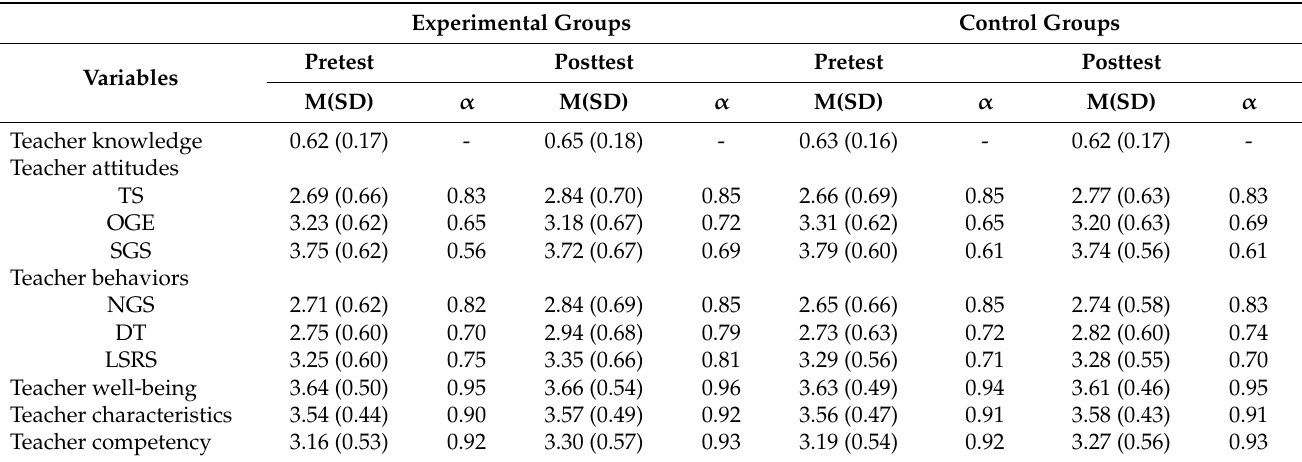
Table 6. Descriptive statistics and reliabilities of all outcome variables for teachers in the experimental and control groups.